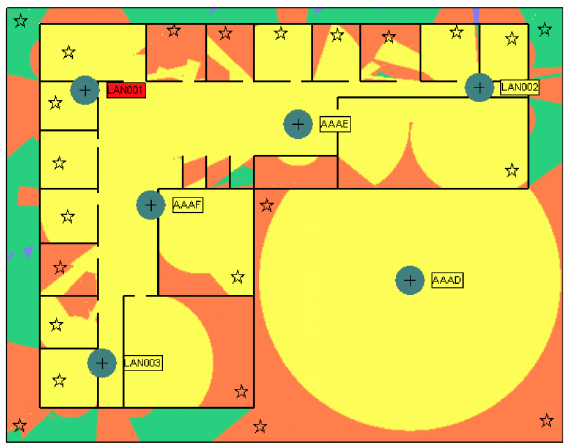
Figure 3. Wireless indoor microcells with six candidate antenna positions and required coverage areas.